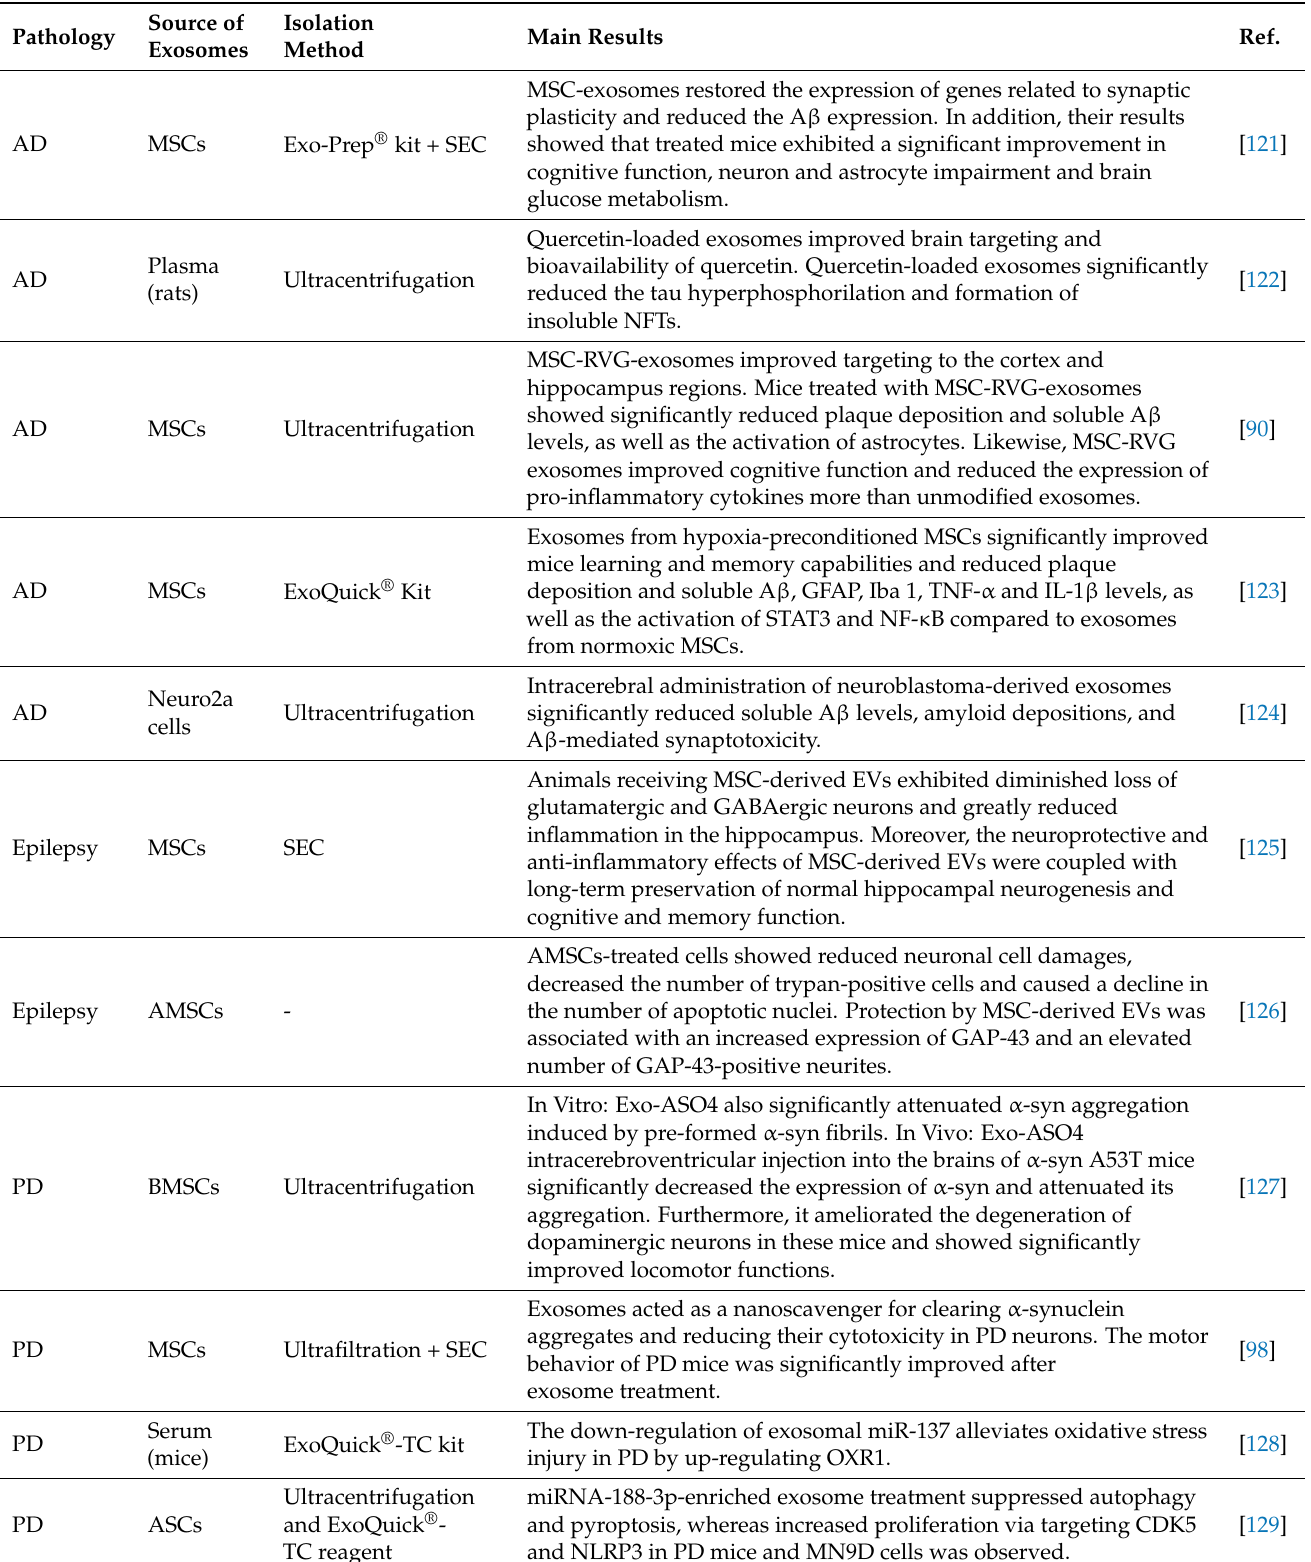
Table 3. Selected relevant studies of recent findings of exosomes-nanomedicine based treatments for neurodegenerative